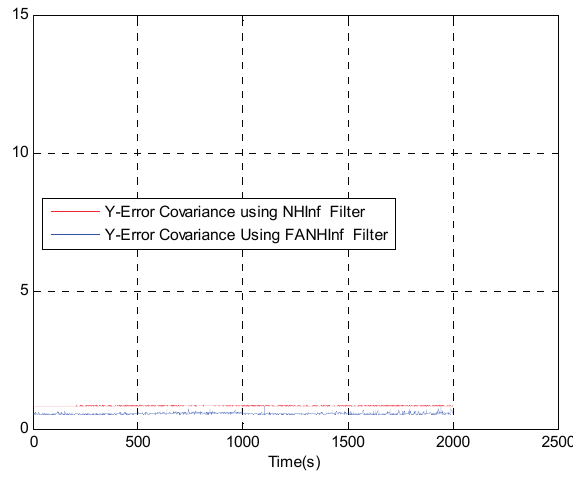
Figure 12. Error covariance in y -axes.